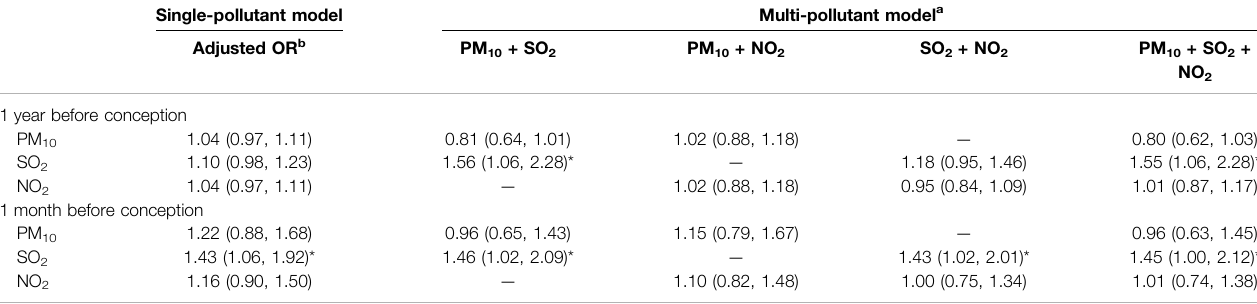
TABLE 2 | Odds ratio of laryngitis due to outdoor air pollution exposure during preconception period among children aged 3 – 6 years ( n = 2,328). Single-pollutant model